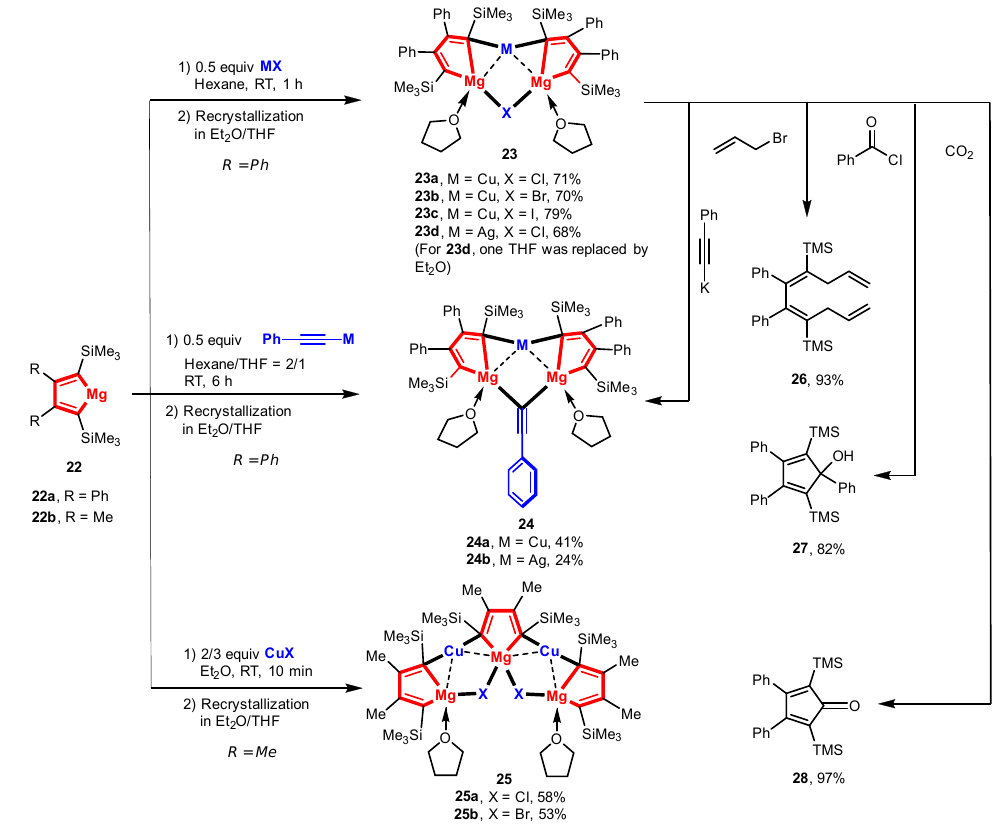
Scheme 6. Rigid magnesium organocuprates